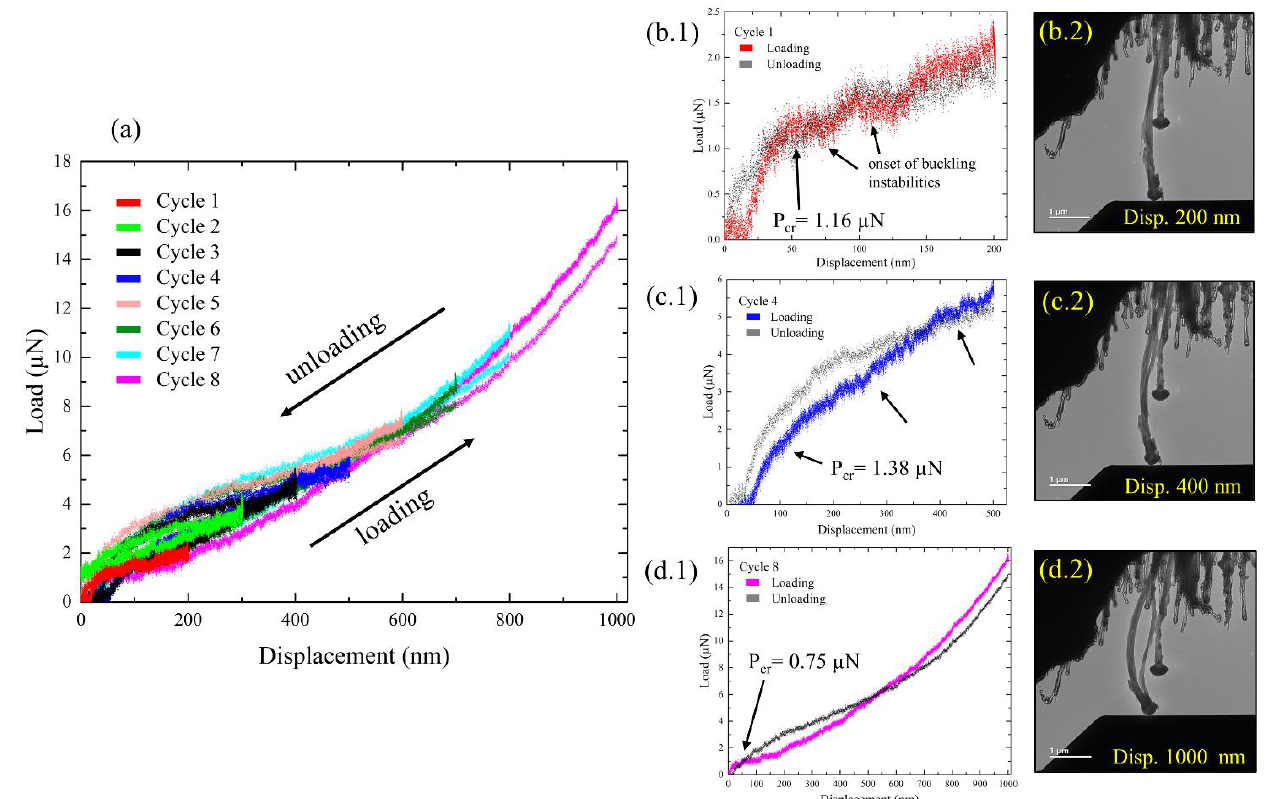
Figure 3. ( a ) Load–displacement curves of eight consecutive compression cycles under axial loading and relaxation. The graph shows increasing displacements and loads for each cycle with a hysteresis. The critical load for buckling ( P cr ) is identified in the load–displacement curves and was used to calculate the modulus via Euler’s column formula. ( b – d ) Snapshots and the corresponding F–D curves of individual cycles, 1 ( b ), 4 ( c ) and 8 ( d ). The curves show the critical point of buckling and ‘pop-in’ events (marked with black arrows), which reveal the onset of buckling instabilities or failure of the inner graphene walls. The P cr values of cycles 1, 4, and 8 are 1.16 µ N, 1.38 µ N, and 0.75 µ N, respectively. TEM images were gathered in bright-field mode at 200